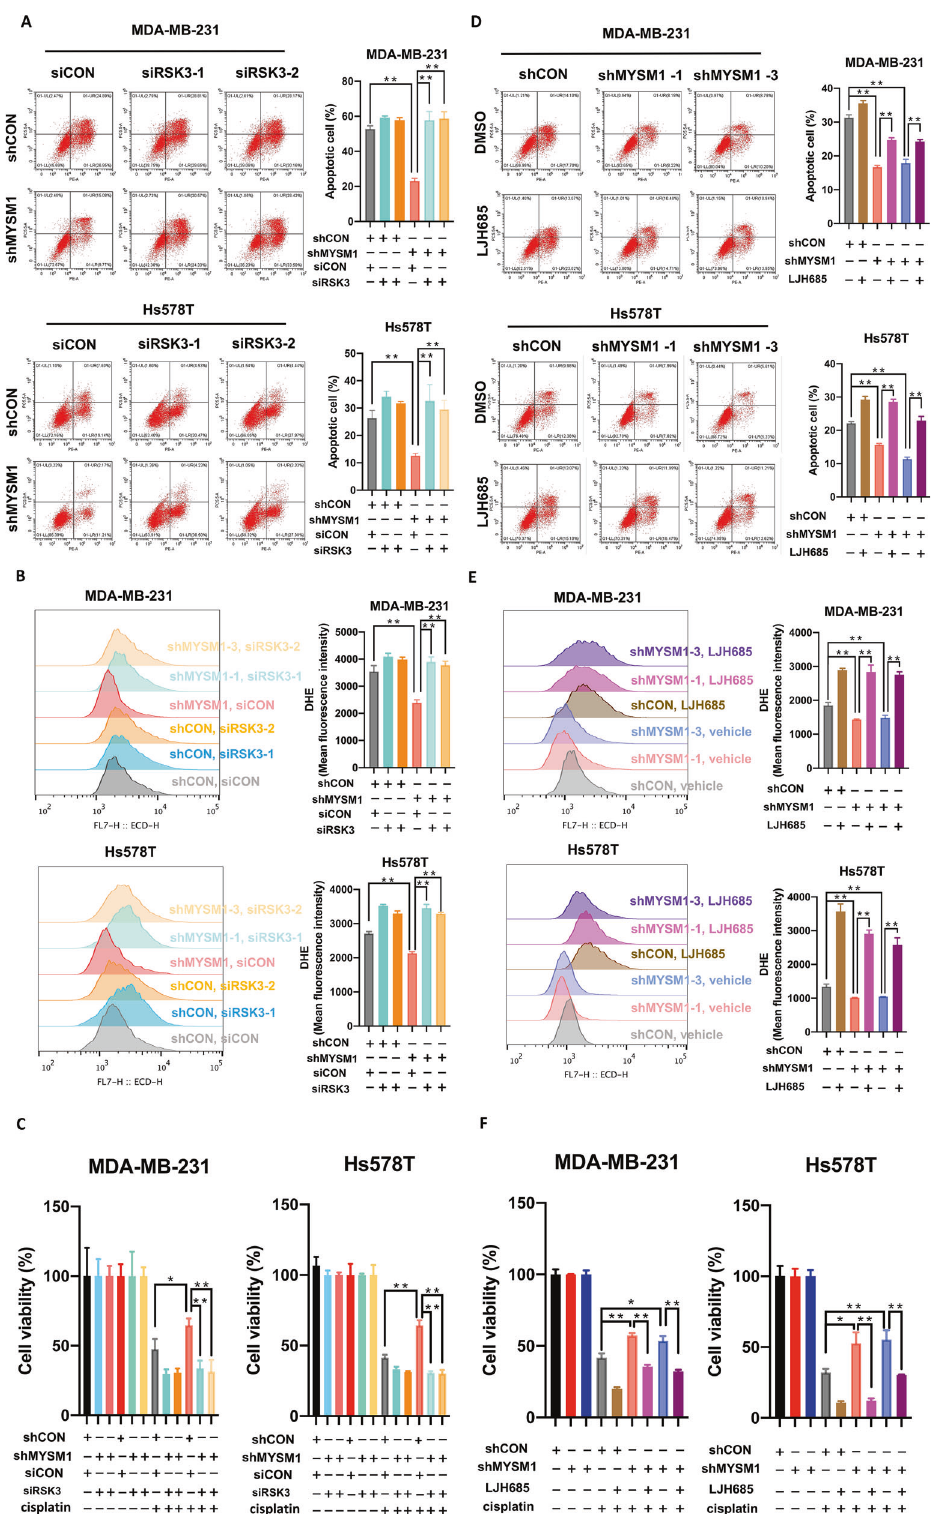
Fig. 5 RSK3, the downstream of MYSM1, regulates cellular apoptosis and induces cisplatin resistance. The siRSK3s or negative control siRNA (siCON) were transfected into MYSM1 knockdown MDA-MB-231 and Hs578T cells, and their corresponding negative control cells. The cells were treated with or without cisplatin (5 µg/mL) for 48 h. A Flow cytometry was performed to detect PE/Annexin V staining and evaluate apoptosis. B Flow cytometry was performed to detect DHE staining to evaluate ROS production. C CCK8 assay was performed to measure the cell viability. The MYSM1 knockdown MDA-MB-231 and Hs578T cells and their corresponding negative controls were pretreated with 50 µM of LJH685 or DMSO for 24 h, followed by changing the medium to cisplatin (5 µg/mL) for 48 h. D Flow cytometry was performed to detect PE/ Annexin V staining and evaluate apoptosis. E Flow cytometry was performed to detect DHE staining to evaluate ROS production. F CCK8 assay was performed to measure cell viability. All data in the graph bars represent means ± SD. * P < 0.05 and ** P <